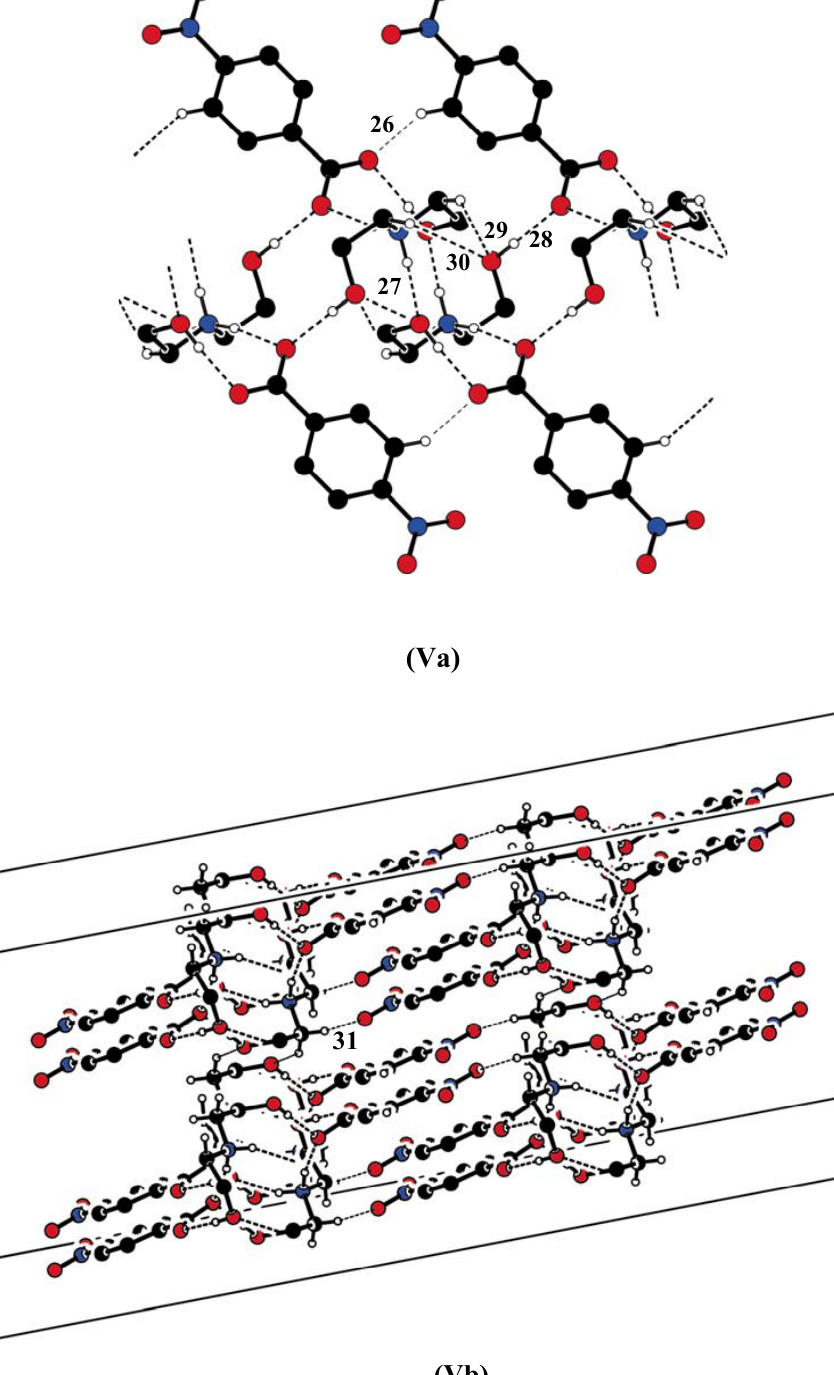
Fig. 6 ( Va ) Fragment of the double chain in V. building blocks form the chains due to translation along b direction via C5 ... O1 (26) hydrogen bonds which are further assembled through the N2 ... O6 (27), O5 ... O2 (28), C8 ... O5 (29), and C10 ... O5 (30) hydrogen bonds (dashed lines). ( Vb ) Fragment of crystal packing showing the weak interactions between double chains via C8 ... O3 (31) hydrogen bonds. Non-functional hydrogen atoms are omitted for